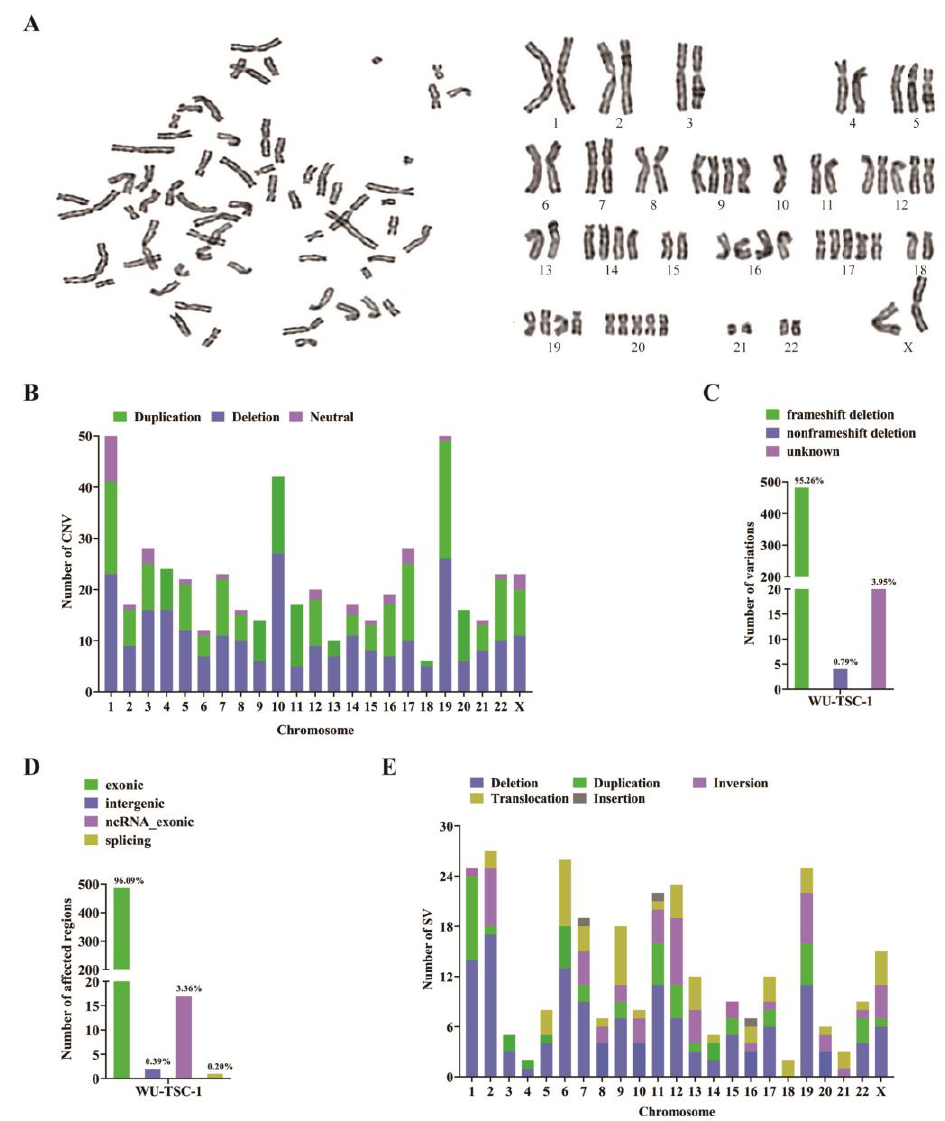
Figure 3. The landscape of chromosome variations: ( A ) The chromosome karyotype of WU-TSC-1. ( B ) Distribution of CNV on chromosomes. ( C ) Functional distribution of CNV mutations. ( D ) Affected regions of CNV mutations. ( E ) Distribution of SVs on chromosomes.